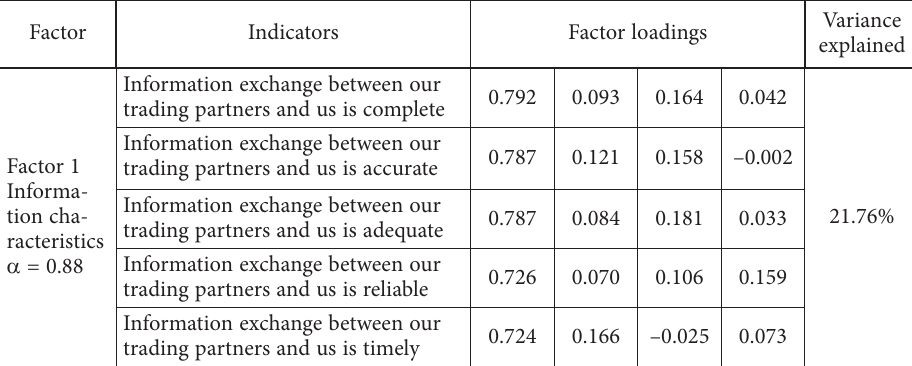
Variance explained